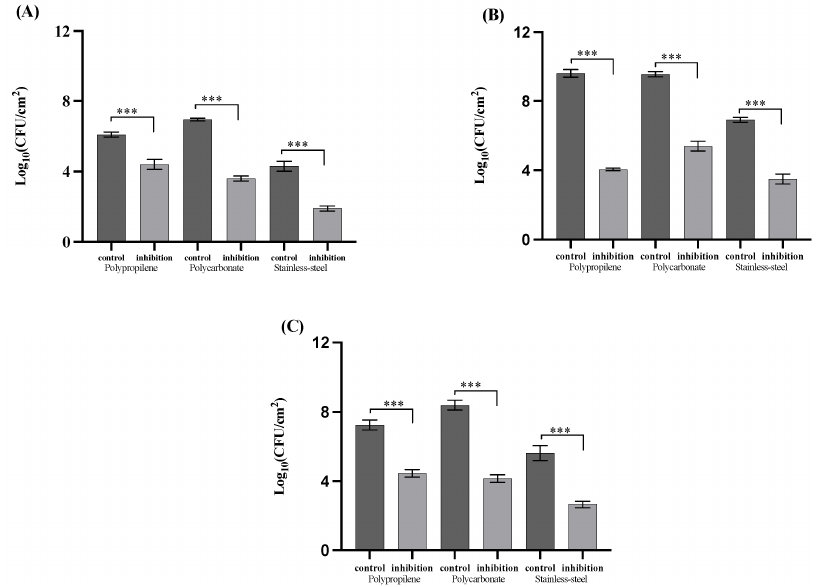
Figure 1. Comparison of limonene inhibition on mono- and polymicrobial mature biofilms (( A ), S. aureus biofilm; ( B ), P. aeruginosa biofilm; ( C ), S. aureus/P. aeruginosa biofilm) grown in dynamic conditions in a CDC reactor on different materials (polypropylene, polycarbonate, and steel). Testing performed in triplicate. Error bars represent standard deviation. Statistical analysis was by two-way analysis of variance (ANOVA) with Tukey’s multi-comparation test (*** p value < 0.001). The mixed S. aureus/P. aeruginosa biofilm (Figures 1 and 2) varies from 10 7 CFU/cm 2